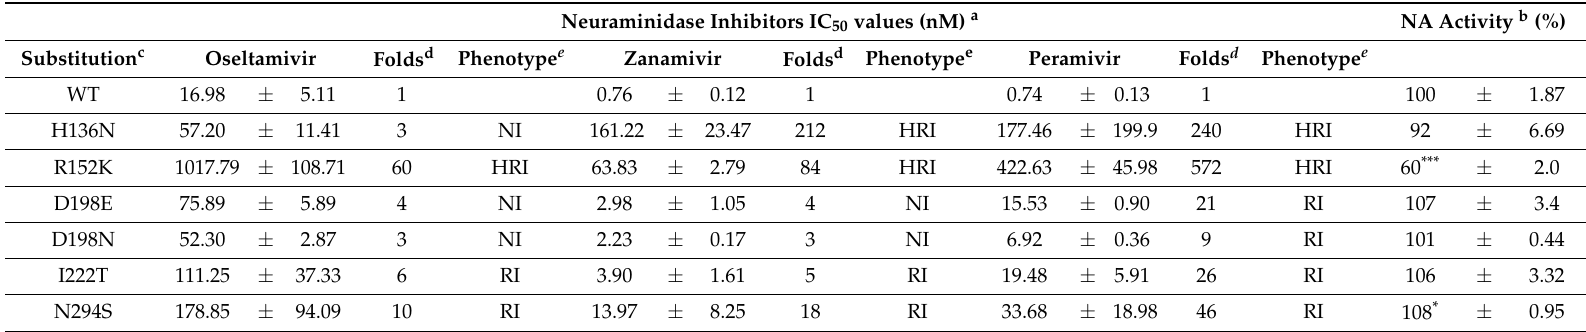
Table 1. Phenotype of resistance to neuraminidase (NA) inhibitors for recombinant influenza B/Phuket/3073/2013